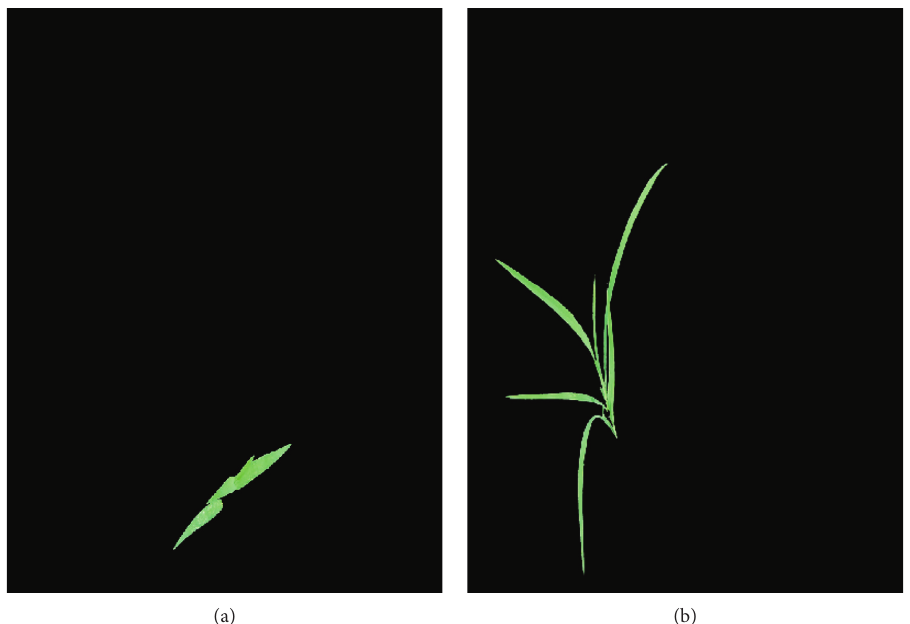
Figure 8: Individual plants extracted for feature extraction. (a) Grass weed. (b) Rice plant.